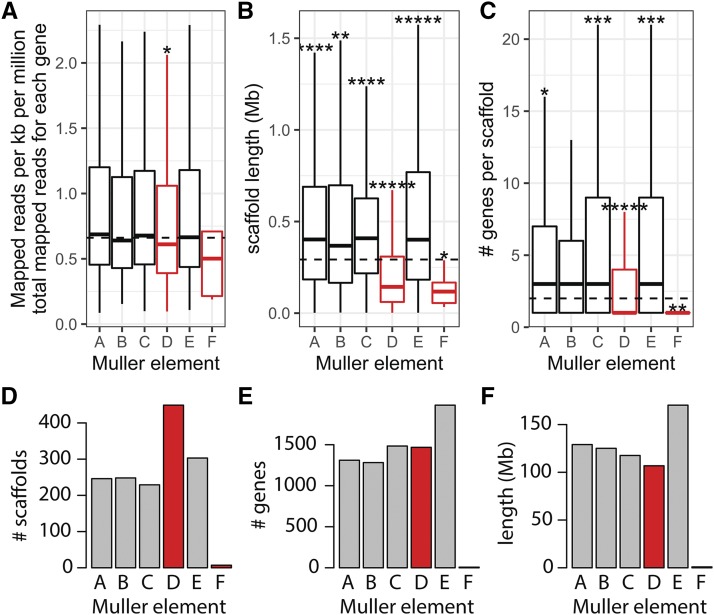
Fragmented assembly of the stable fly sex chromosome. A. The distributions of the number of reads mapped to genes assigned to each Muller element are shown with boxplots. B. The distributions of scaffold lengths and C. the distributions of genes per scaffold for scaffolds assigned to each stable fly Muller element are shown with boxplots. Outliers are omitted from each boxplot to more clearly show the majority of data. Dashed lines indicate the median value across all genes assigned to a Muller element. Asterisks represent p-values from Mann-Whitney tests comparing each Muller element with the other five elements (*P<0.05, **P<0.005, ***P<0.0005, ****P<0.00005, *****P<0.000005). D. The number of genomic scaffolds and E. the number of genes assigned to each stable fly Muller element. F. The composite length of all scaffolds assigned to each stable fly Muller element. Inferred sex-linked elements are highlighted in red.